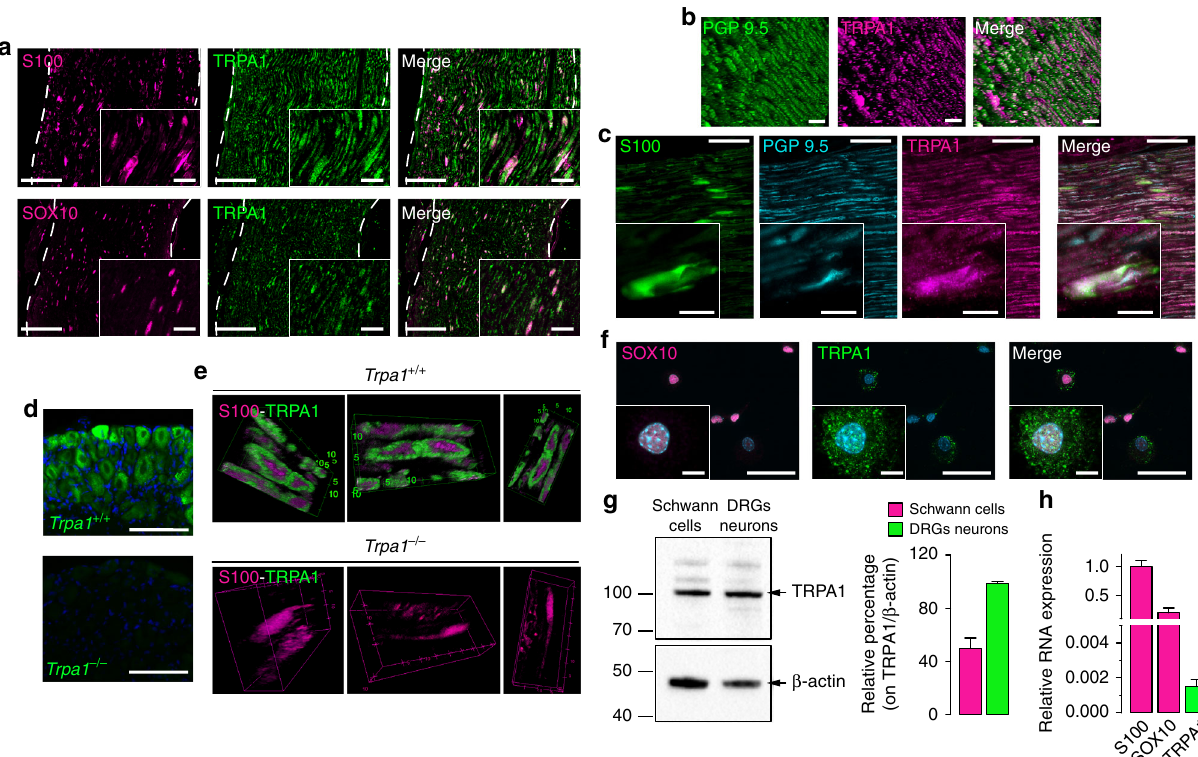
Fig. 3 Schwann cells express TRPA1. a Double immuno fl uorescence staining of TRPA1 and S-100 and SOX10 (two speci fi c markers for detecting Schwann cells), in sciatic nerve from C57BL/6 mice (Scale bars: 50 μ m and inset 20 μ m). b 3D confocal images of TRPA1 and PGP9.5 staining in Schwann cells from sciatic nerve trunks of C57BL/6 mice (Scale bars: 20 μ m). c Triple immuno fl uorescence staining of S-100, PGP9.5 and TRPA1 in sciatic nerve trunks from C57BL/6 mice (Scale bars: 20 μ m and inset 10 μ m). d TRPA1 staining in DRGs neurons from Trpa1 +/+ and Trpa1 − / − mice (Scale bars: 50 μ m). e 3D confocal image reconstructions of TRPA1 and S100 in Schwann cells from sciatic nerve trunks of Trpa1 +/+ and Trpa1 − / − mice. f TRPA1 and SOX-10 immunoreactivity in cultured C57BL/6 mouse Schwann cells (Scale bars: 50 μ m and inset 10 µ m). g Representative blot and TRPA1 protein content in cultured Schwann cells and DRGs neurons taken from C57BL/6 mice. Equally loaded protein was checked by expression of β -actin ( n = 4 independent experiments). h TRPA1 mRNA relative expression in cultured C57BL/6 mouse Schwann cells ( n = 3 replicates from two independent experiments). Data are represented as mean ±